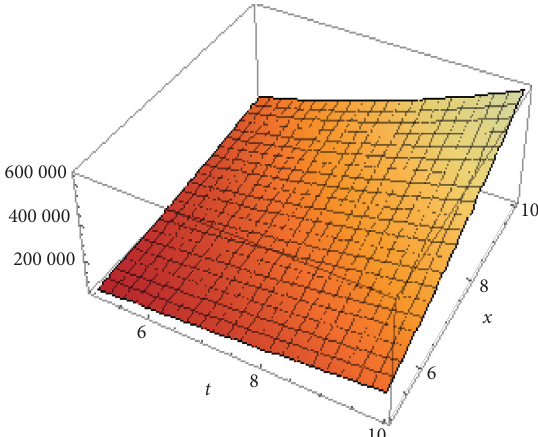
Figure 1: 3D plot of equation (60) for α � 0 . 50 ; β � 0 . 25 ; y � 1.